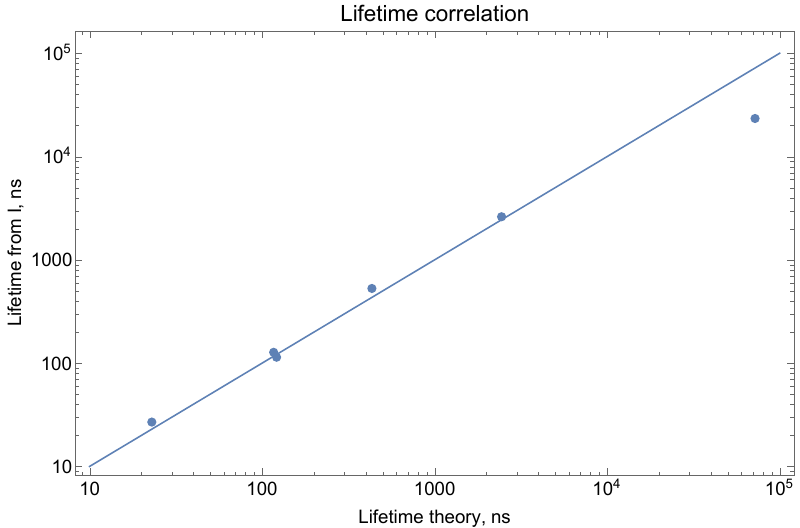
Figure 2. Comparison between theory and experiment for lifetimes of J=1.5 odd states. Because of strong mixing for many groups of states (#2-5, #6-8, #9-14, #15-16, #17-18), their average lifetimes were plotted with the average energy used in the LTE equation. The lifetimes derived from experimental intensities “Lifetimes from I” (the sum of intensities given by NIST for a transition from a specific level) were scaled with Boltzmann factor Exp[-E/T] and multiplied by a coefficient for the best match: T = 4500 cm − 1 and k = 500. The data are also presented in Table 7. Table 7. Lifetime calculations for J = 1.5 odd states using CI-MBPT “ τ th ” and comparison with lifetimes τ I derived from the sum of intensities. The difference allows us to estimate the error of